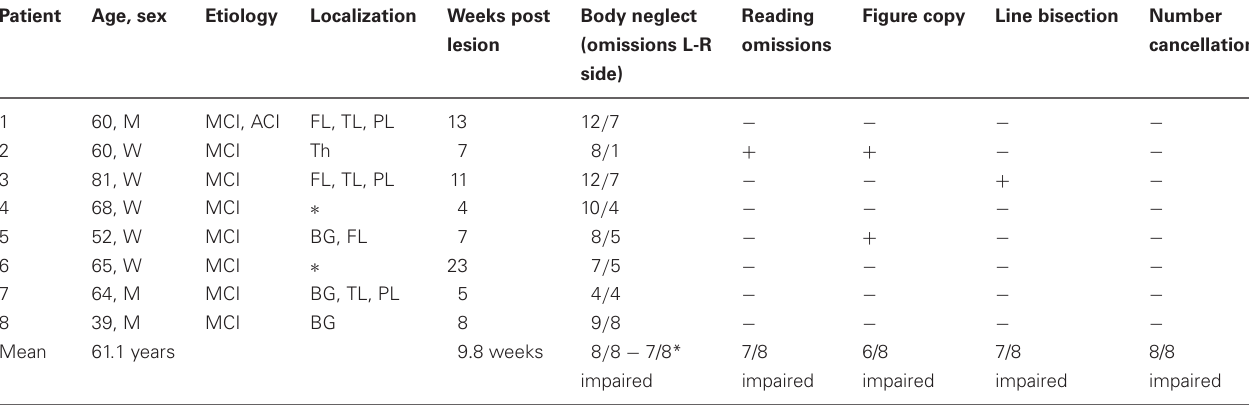
Table 1 | Clinical and demographic data of the eight patients with left visual neglect after a single vascular lesion of the right hemisphere.